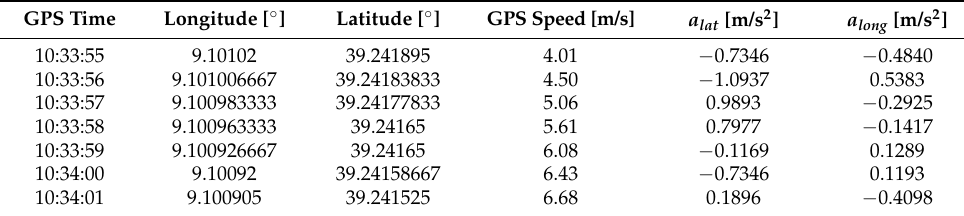
Table 2. Location-at-time raw data sample gathered by the app Torque on Tue Jul 2018 [43]. GPS Time